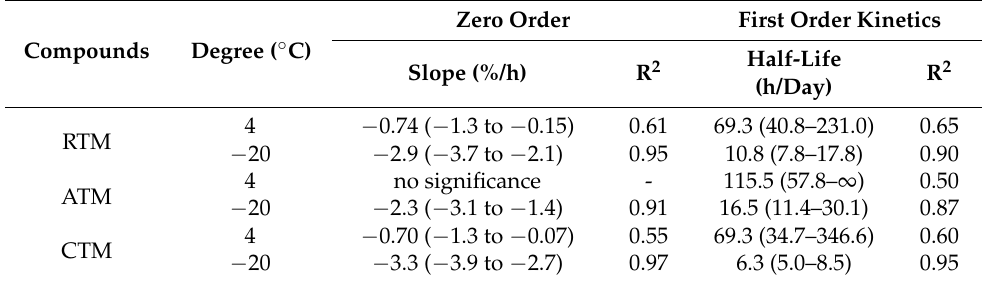
Figure 2. Analytes’ stability in wastewater kept under different conditions: ( a – c ) parents antibiotics stability profiles in wastewater kept at pH 3 and 4 °C for 48 h, pH 3 and −20 °C for 30 d, and pH 3 and −80 °C for 30 d; ( d – f ) metabolites stability profiles in wastewater kept at pH 3 and 4 °C for 48 h, pH 3 and −20 °C for 30 d, and pH 3 and −80 °C for 30 d. Table 3. Zero and first order kinetics to model macrolide antibiotics in laboratory wastewater under 4 ◦ C and − 20 ◦